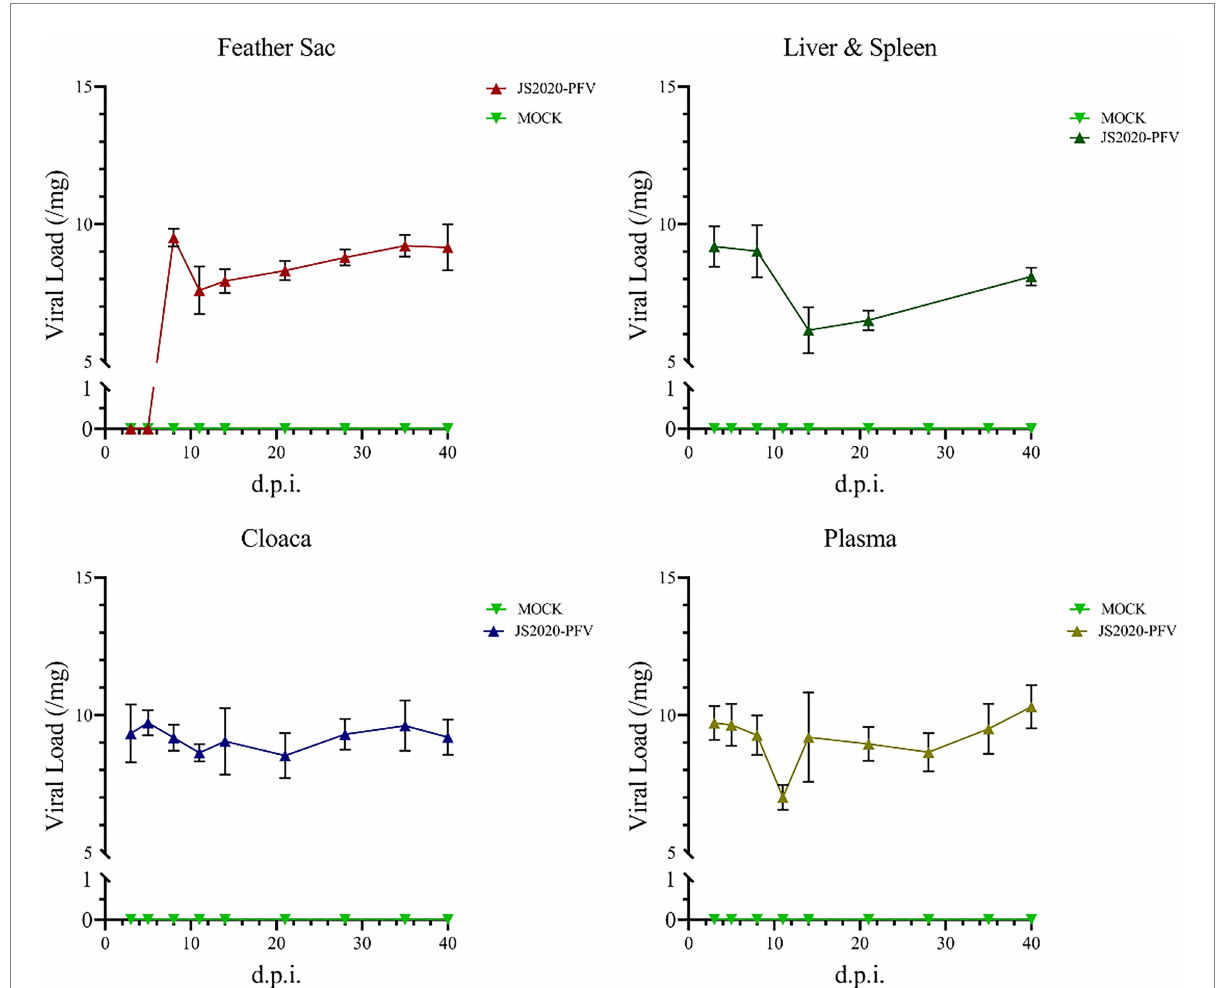
FIGURE 10 Detection of nucleic acids in the JS2020-PFV group ( n = 4 per group). Viral Load = log 10 virus copies. In the JS2020-PFV group, the chicken infectious anemia virus was detected at 8 d.p.i. in the feather sac and at 3 d.p.i in the cloaca, plasma, liver, and spleen. The viral load was relatively low in the liver and